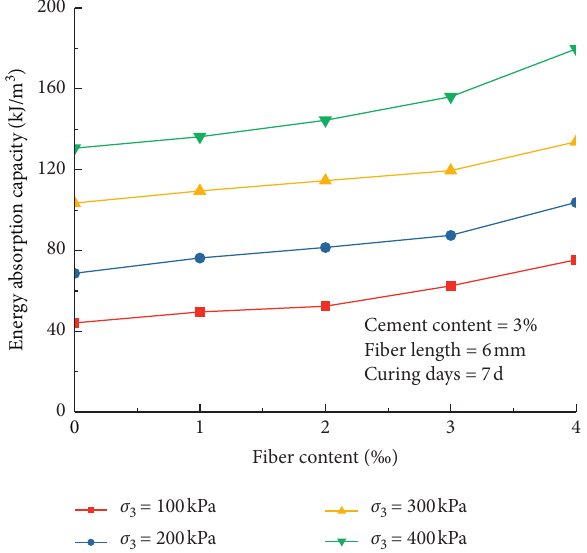
Figure 17: Energy absorption capacity under different fiber contents.